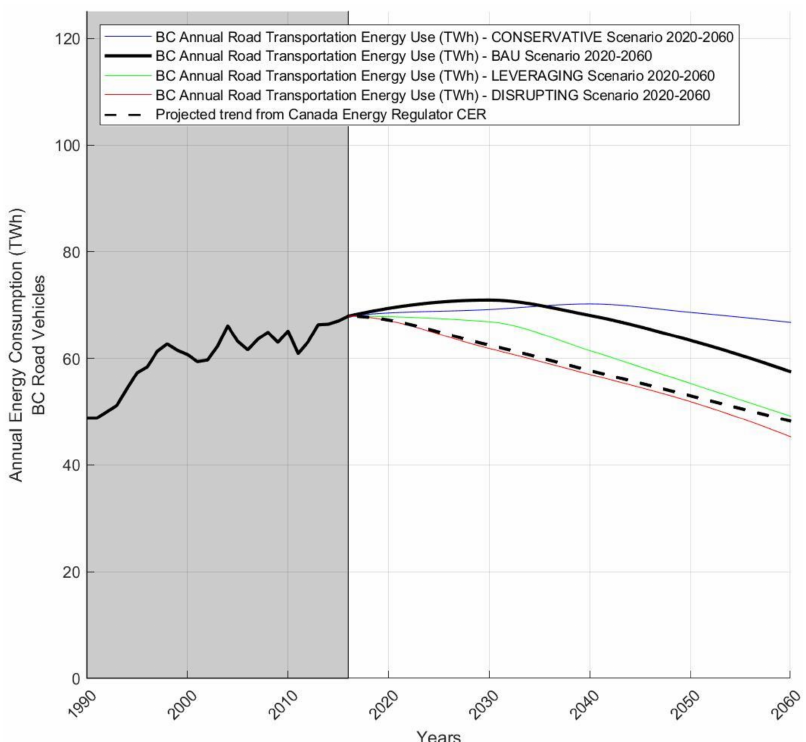
Figure 10. B.C. road transportation annual energy use in (TWh), impacts of vehicle electrification, travel demand increases due to vehicle automation and increased energy use of automated vehicles arising from fueling, charging, and